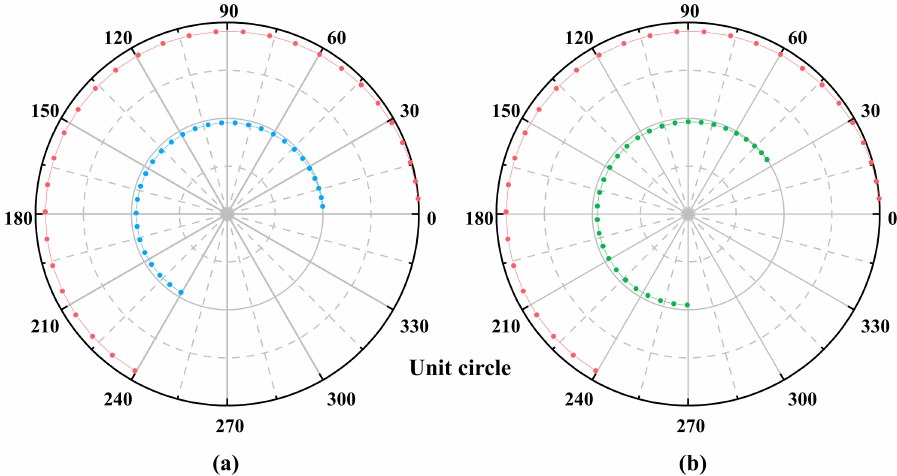
Figure 13. The complex correction term γ e changes the position of the LUT in the complex plane unit circle. ( a ) In order for | γ e | to reduce the coherence amplitude of the LUT points, the curve composed of red points is the LUT calculated by the original RVoG model, and the curve composed of blue points is the LUT after | γ e | correction, and its more suitable for the inversion of low coherence cases. ( b ) Shows the LUT after ϕ e is introduced on the basis of ( a ), and the curve composed of green points is the LUT after ϕ e correction, which is more suitable for inversion of data with obvious phase center shift. σ is 0.2, k z is 0.01, ε is 15, and the forest height range is 0–30 m with 1 m interval between two